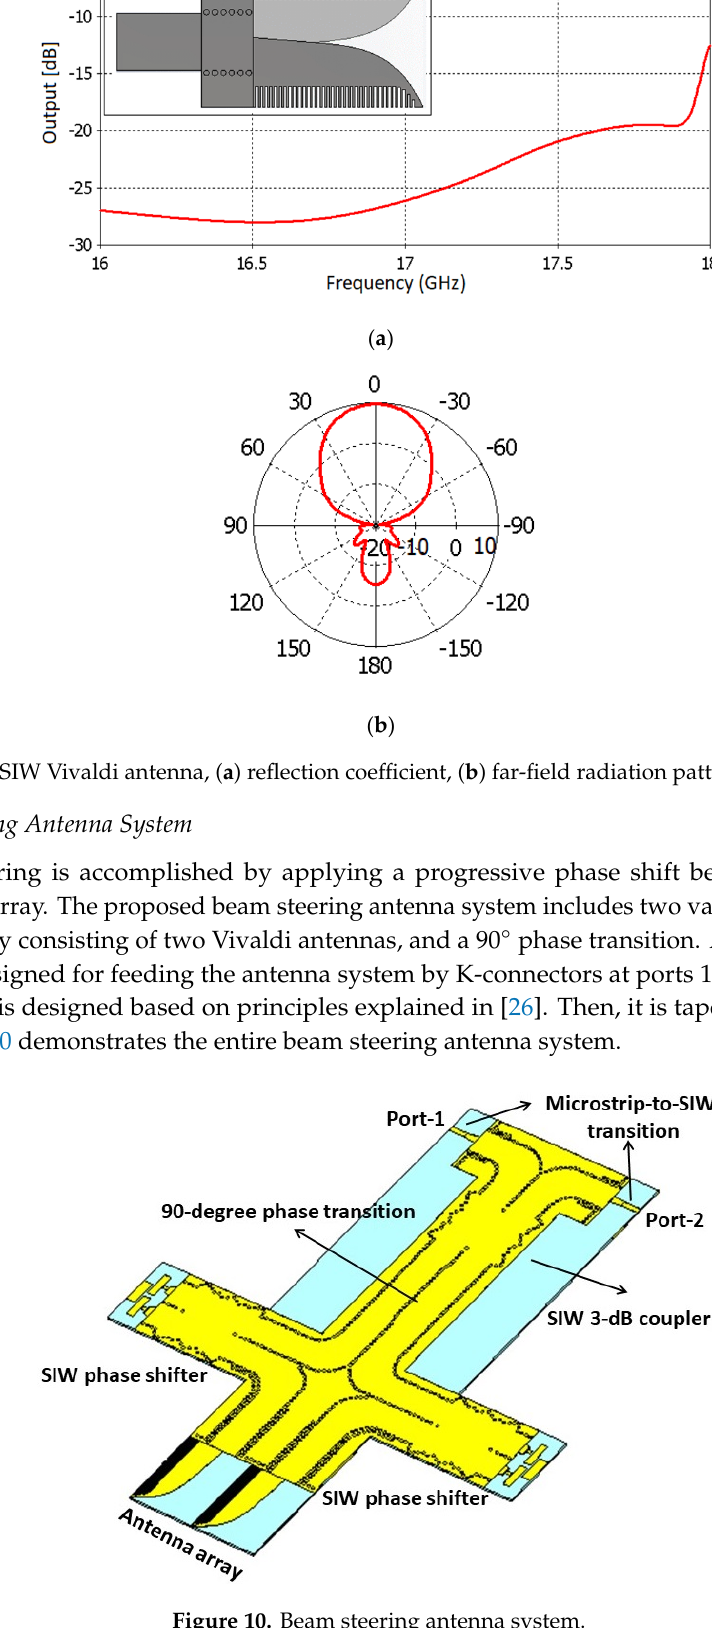
Figure 10. Beam steering antenna system.